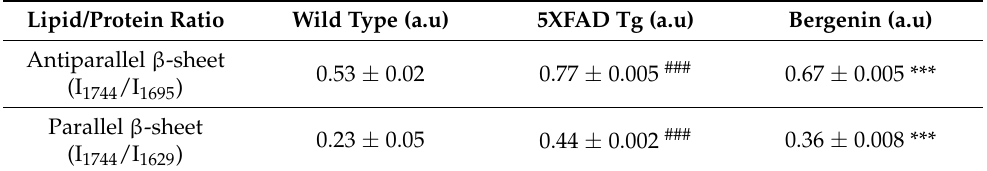
Table 2. FT-IR absorption band area ratio for selected bands of wild-type, 5xFAD, Tg and Bergenin- treated hippocampal regions of mouse brains.